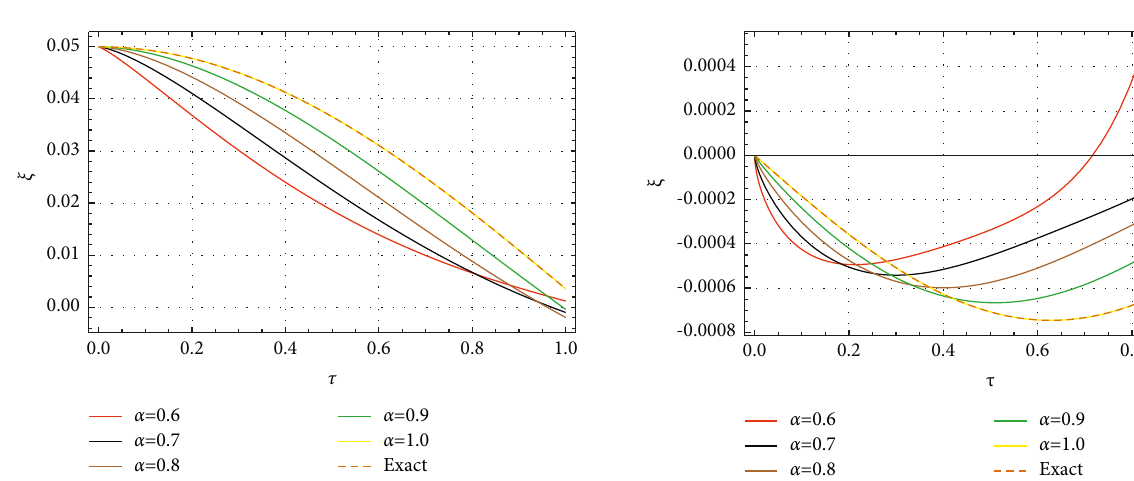
Figure 8: The approximate and exact solutions to the imaginary part of Example 4.